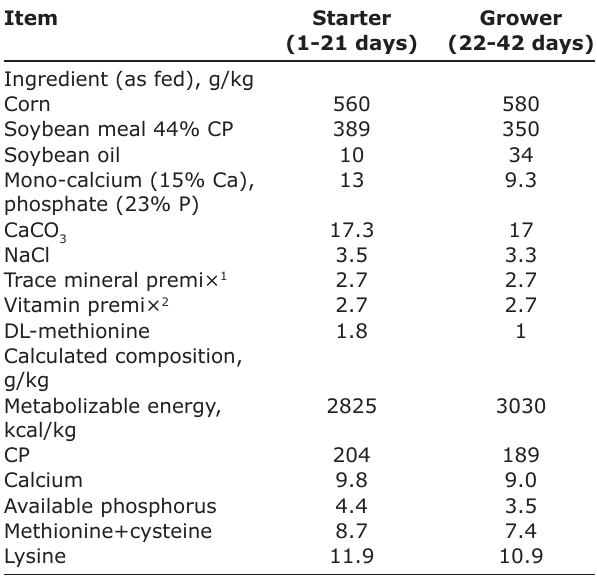
Table-1: The ingredient and calculated composition of basal starter, and grower diets (as-fed basis).